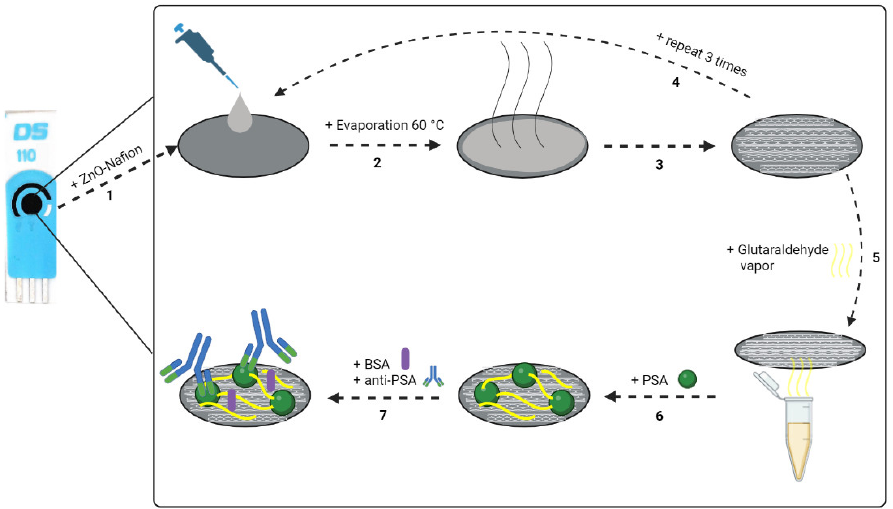
Figure 9. Schematic representation of SPCE modification: 1—ZnO-Nafion deposition; 2,3—evaporation at 60 °C; 4—the drop-casting procedure was repeated 3 times; 5—incubation in glutaraldehyde vapor; 6—immobilization of PSA; 7—blocking of the remaining free surface of the pre-modified electrode with 2% BSA, following the affinity interaction with anti-PSA.